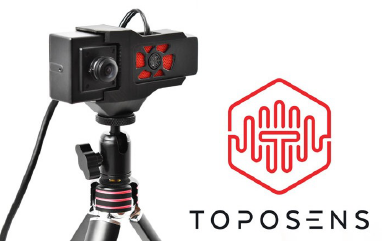
Figure 1. Toposens TS Alpha 3D ultrasonic sensor [12].